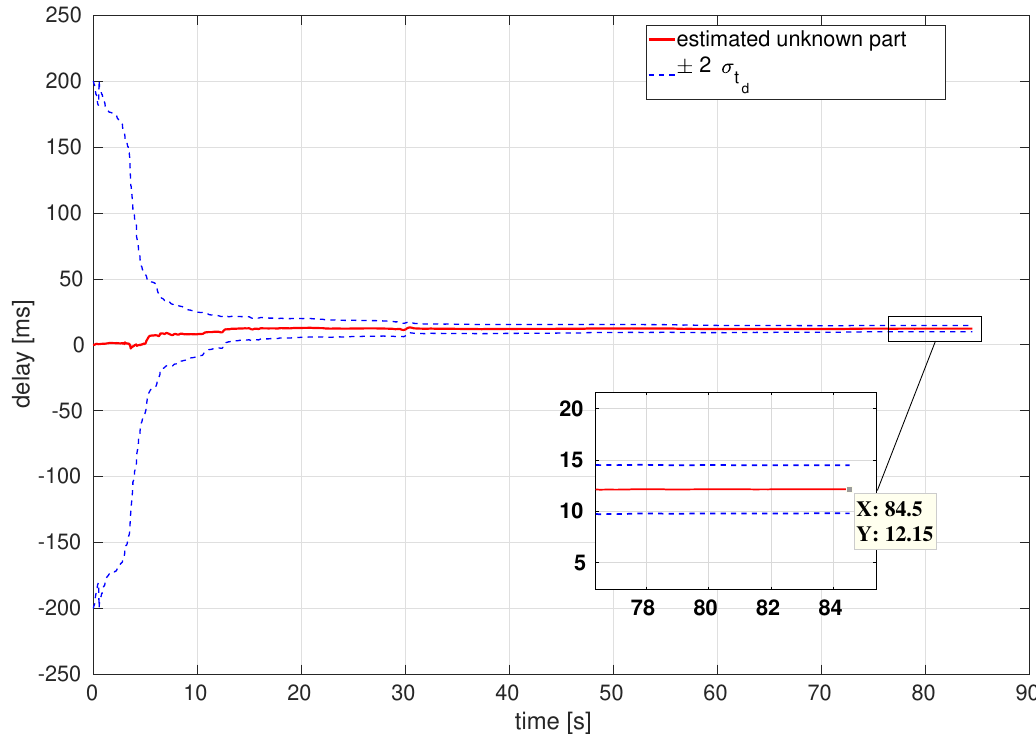
Figure 12. Estimation of unknown part of time delays of the EuRoC V1 medium dataset.